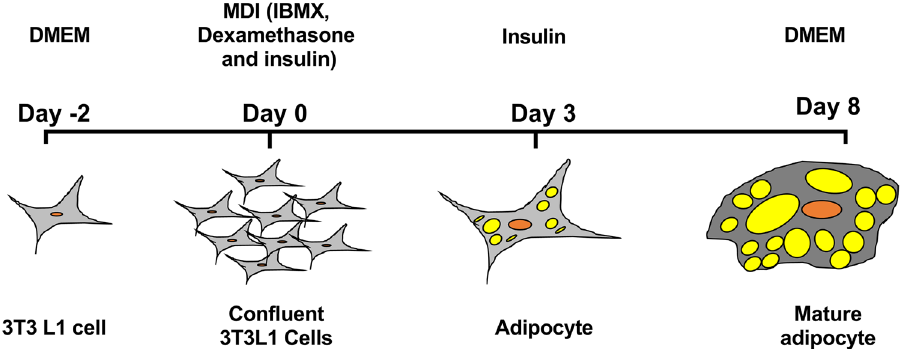
Figure.10:. Schematic of procedure for the differentiation of 3T3-L1 pre-adipocytes into mature